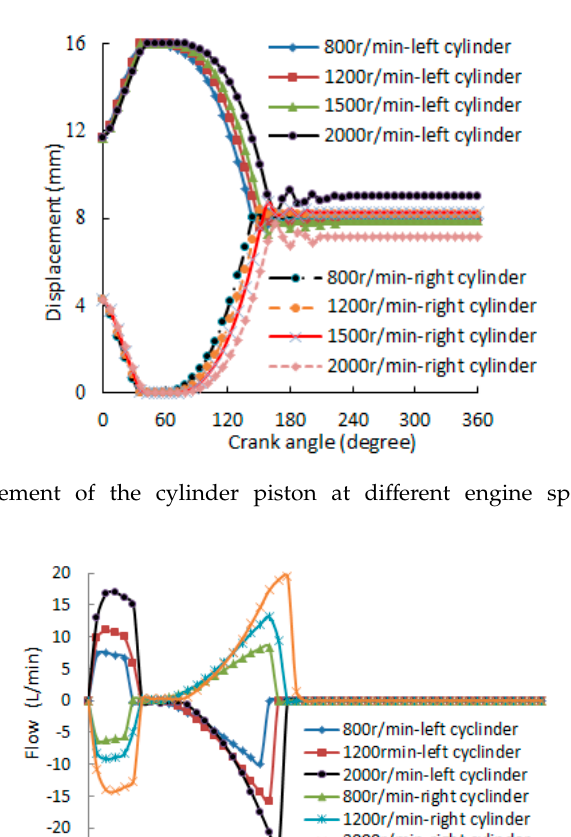
Figure 8. Pressure of the left cylinder at different engine speeds with the same adjustment quantity. Figure 9 presents the simulation results of left cylinder piston displacement and right cylinder piston displacement at 800 r/min, with different adjustment quantities. From the figure, we can see that the displacement of the left cylinder piston increases gradually to the stroke of the left cylinder,